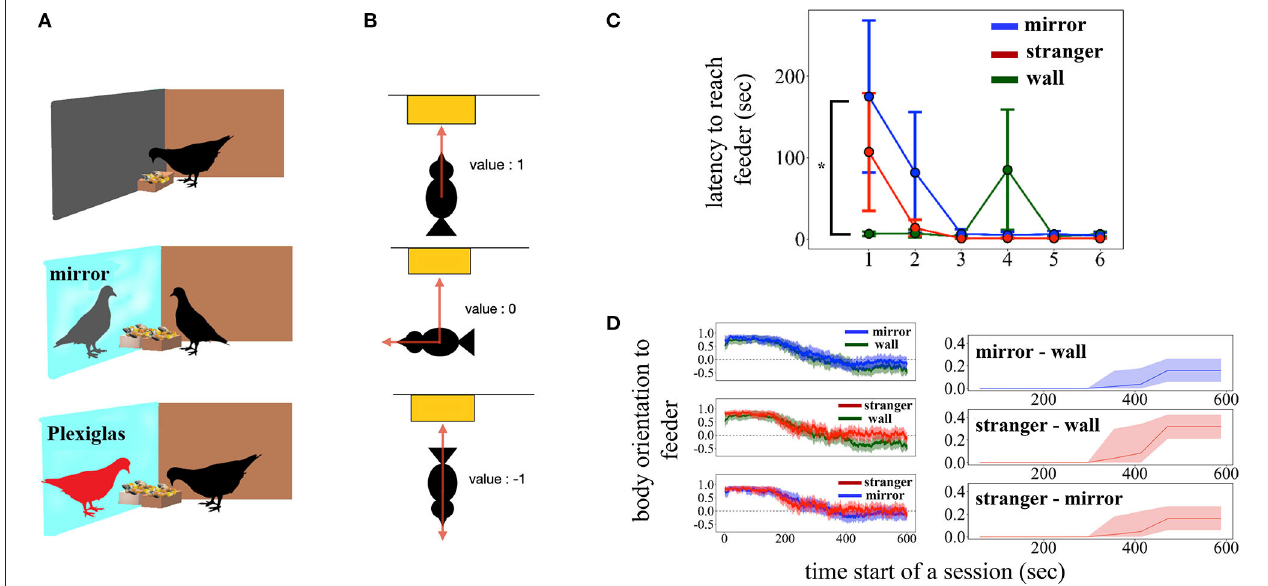
FIGURE 1 | (A) Schematic illustration of the experimental setup in the Wall, Mirror and Stranger conditions, top to bottom, respectively. (B) Schematic illustration of the body orientation indexes. The value of 1 indicates a body orientation toward feeder/mirror, − 1 is an orientation opposite to feeder/mirror, and 0 describes an orientation of 90 ◦ relative to feeder/mirror. (C) Latency to approach the feeder. (D) Left , mean body orientation indexes across time. Filled regions represent SEM. Right -time-series modeling revealed the differences between two conditions. Lines represent posterior mean and shaded areas 95% credible intervals. * p <